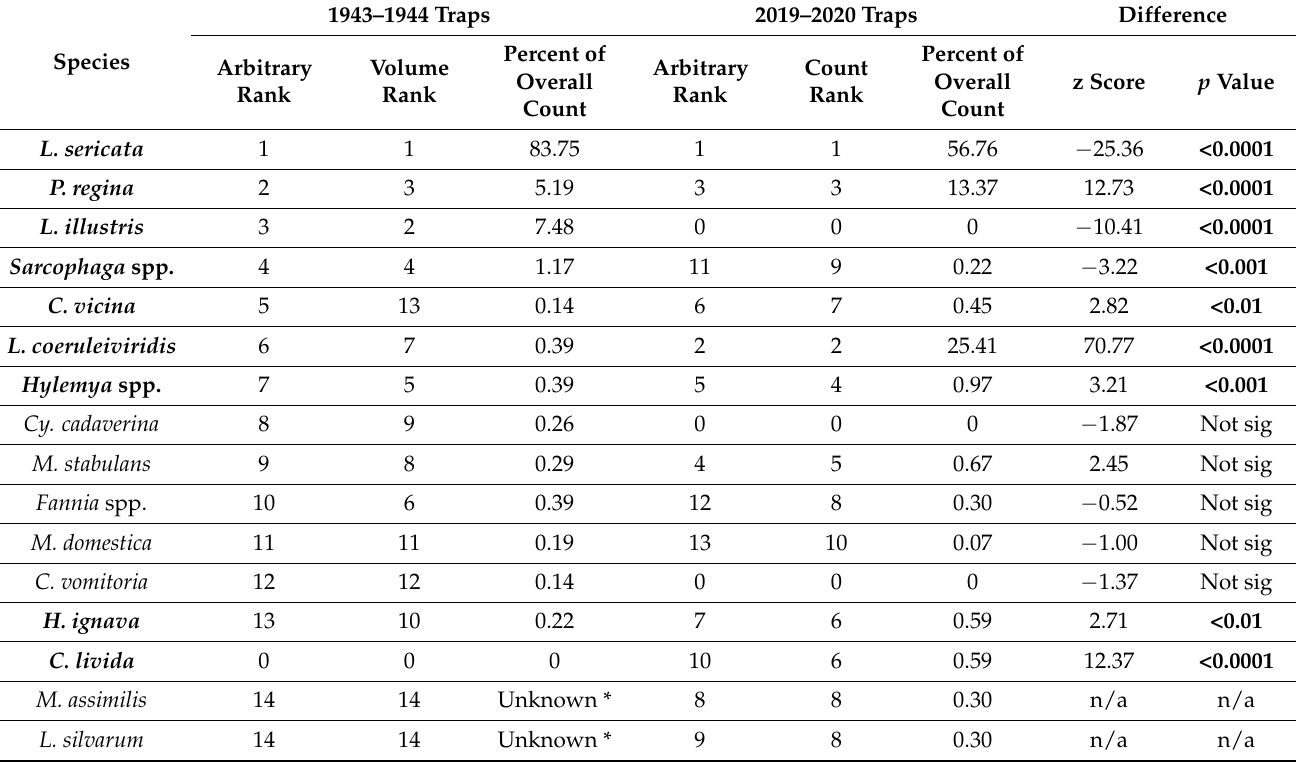
Table 3. Comparison of fly species trapped in the 1940s and current survey. Species with a significantly different fly count between surveys are in